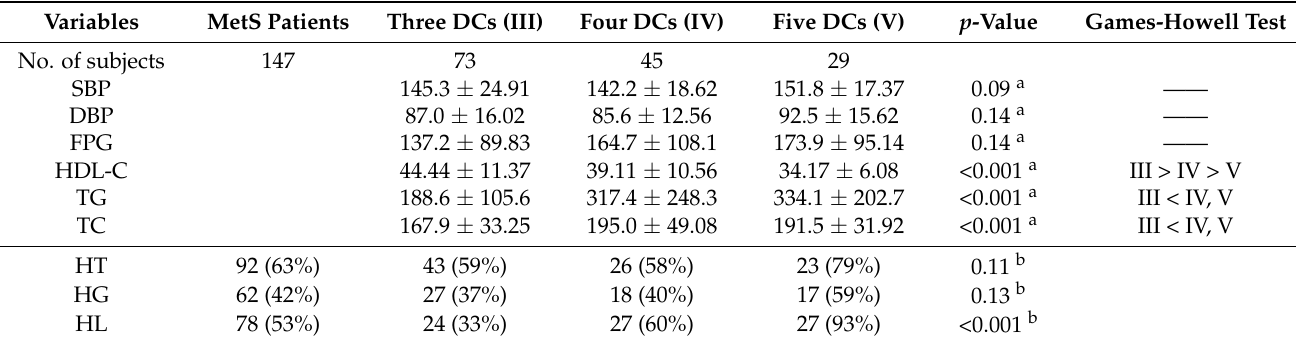
Table 4. Comparison of cardiovascular disease (CVD) risks in patients with different degrees of metabolic syndrome